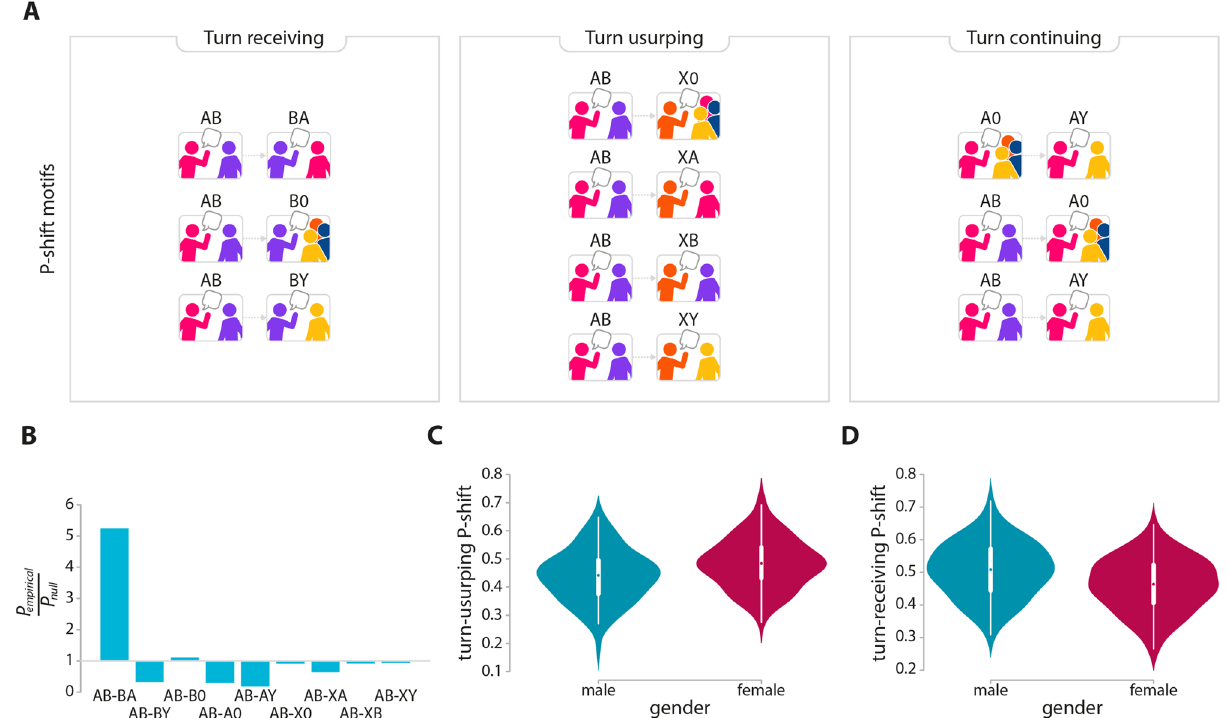
Figure 3. Microscopic nature of team interactions. We identify ordered communication sequences in escape rooms by Gibson’s Participation Shift Profile framework 44 . P-shift motifs started with a directed remark (pairwise) can be clubbed up into 3 categories denoting the way by which the second speaker gets the turn ( A ). The prototypical turn-receiving P-shift AB-BA (which refers to an immediate reciprocation by B is overrepresented at the expense of AB-BY , while pairwise turn-continuing motifs such as AB-AY and AB-A0 are underrepresented in escape rooms ( B ). Men and women participate differently in team conversations, with women showing lower levels of turn-receiving behaviour ( C ). This is probably connected to the observation that women are more likely to usurp turns ( D ) to express their opinion, as they rarely receive it. Panel ( A ) is produced by Szabolcs